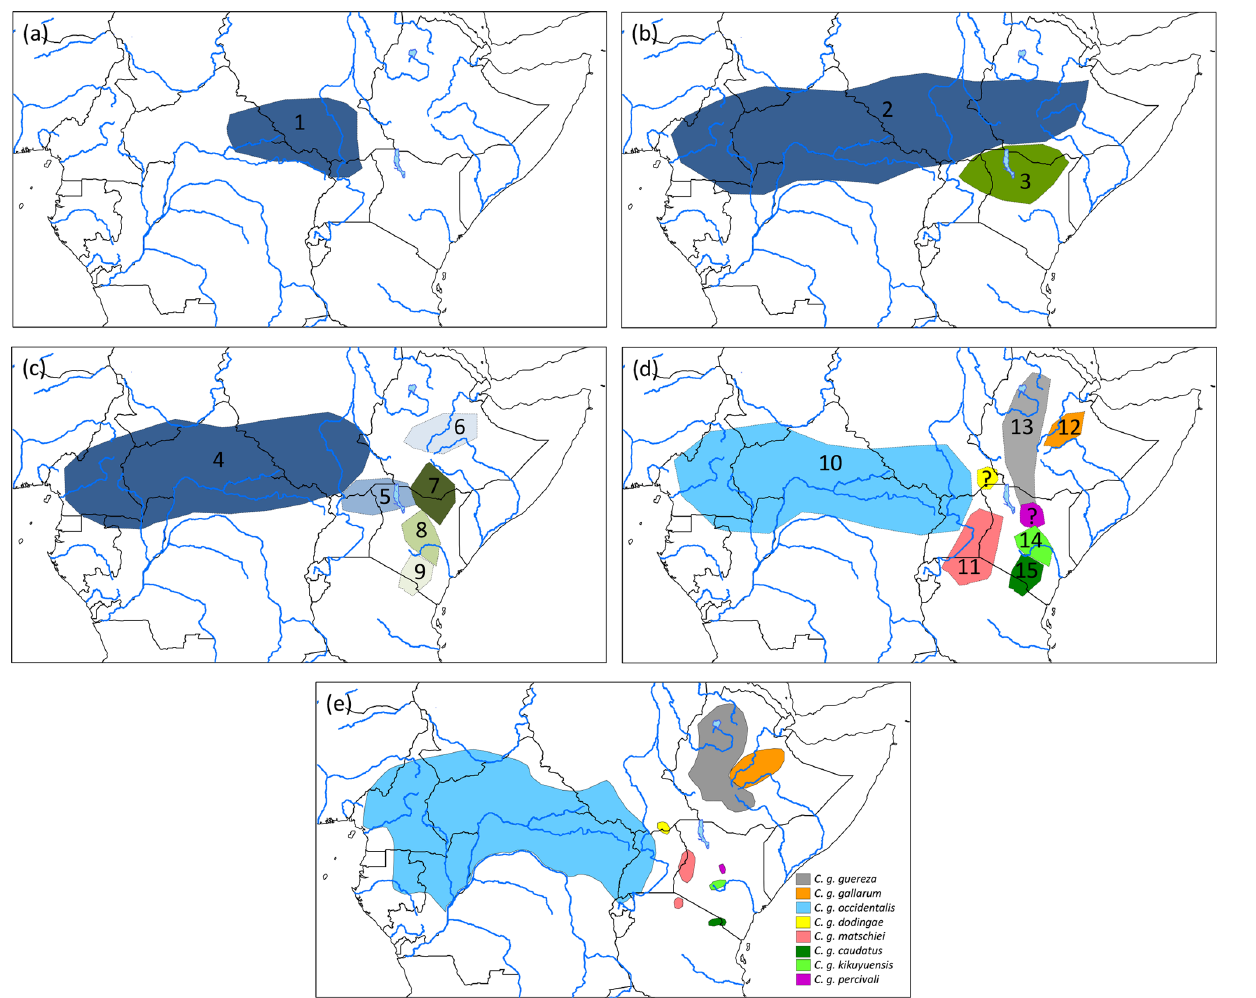
Figure 3. Phylogeographic scenario for Colobus guereza . (a) Ancestral population (1) in the northern forest belt; (b) distribution of two subpopulations after the first split of the ancestral lineage into ancestral populations of C. g. occidentalis + C. g. matschiei + C. g. gal- larum (2) and C. g. caudatus + C. g. kikuyuensis + C. g. guereza (3); (c) further split of population (2) into ancestral C. g. occidentalis